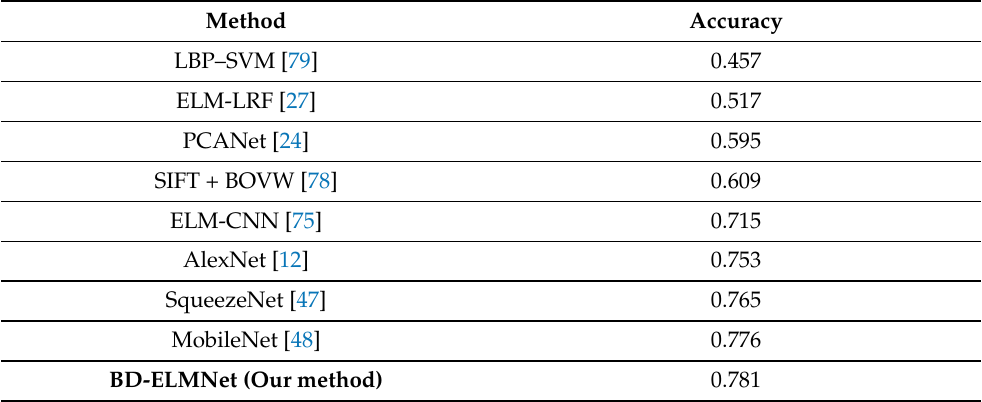
Table 5. Experimental results of different classification algorithms on the MTARSI